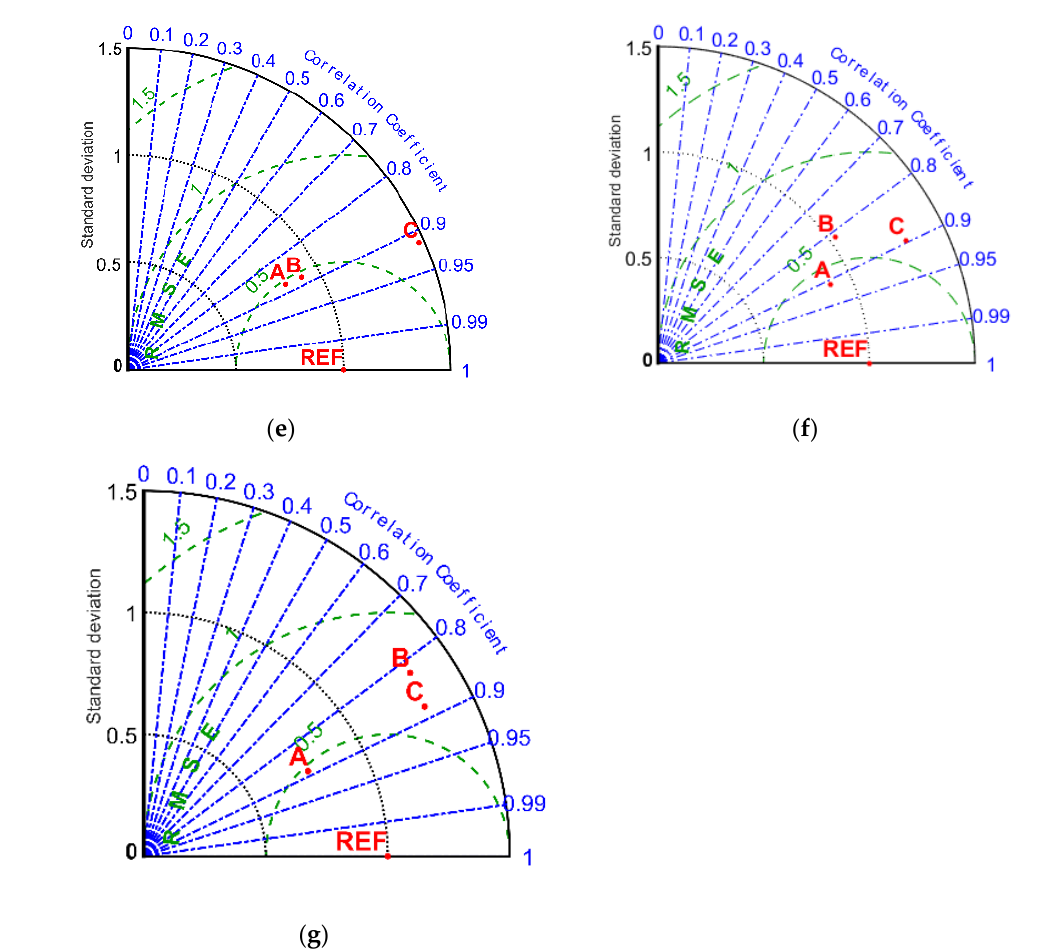
Figure 3. Comparative analysis of the precision of different precipitation forecasting models at different time scales. Figures show the results at different scales. ( a ) Year. ( b ) Crop growth period. ( c ) May. ( d )June. (e) July. ( f ) August. ( g ) September. A, B and C represent the methods of MGSM, GSM, and GM(1,1) respectively. REF is the reference point.